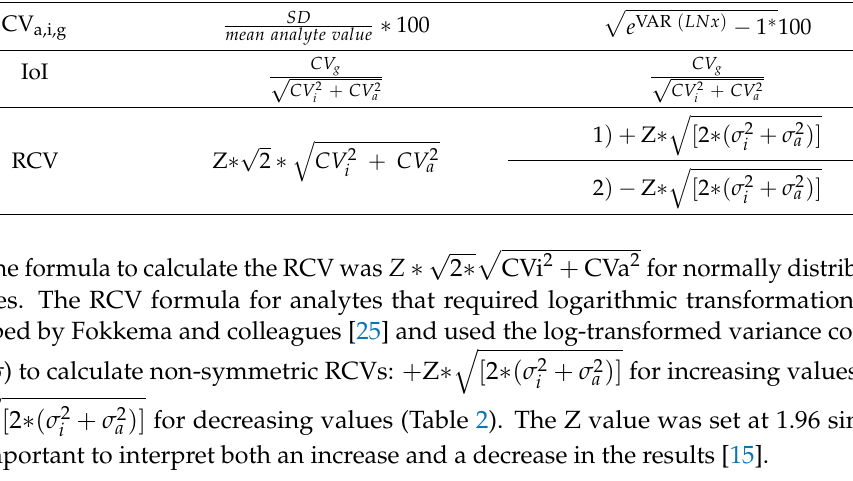
Table 2. Formulas used to calculate the coefficients of variation (CVs), the index of individuality (IoI), and the reference change value (RCV). SD = standard deviation, e = Nepero’s number, VAR is the vari- ance of the data distribution, LN = natural logarithm, x = number of animals, CV g = between-animals coefficient of variation, CV i = within-animal coefficient of variation, CV a = analytical imprecision, Z = 1.96, σ and σ a = within-animal and analytical variance of the Gaussian distribution. i Normal Distribution Non-Normal Distribution (cid:112) ∗ 100 CV a,i,g SD e VAR ( LNx ) − 1 ∗ 100 mean analyte value CV g √ IoI CV g √ CV 2 i + CV 2 a CV 2 i + CV 2 a ∗√ (cid:113) + CV 2 CV 2 2 ∗ RCV Z i